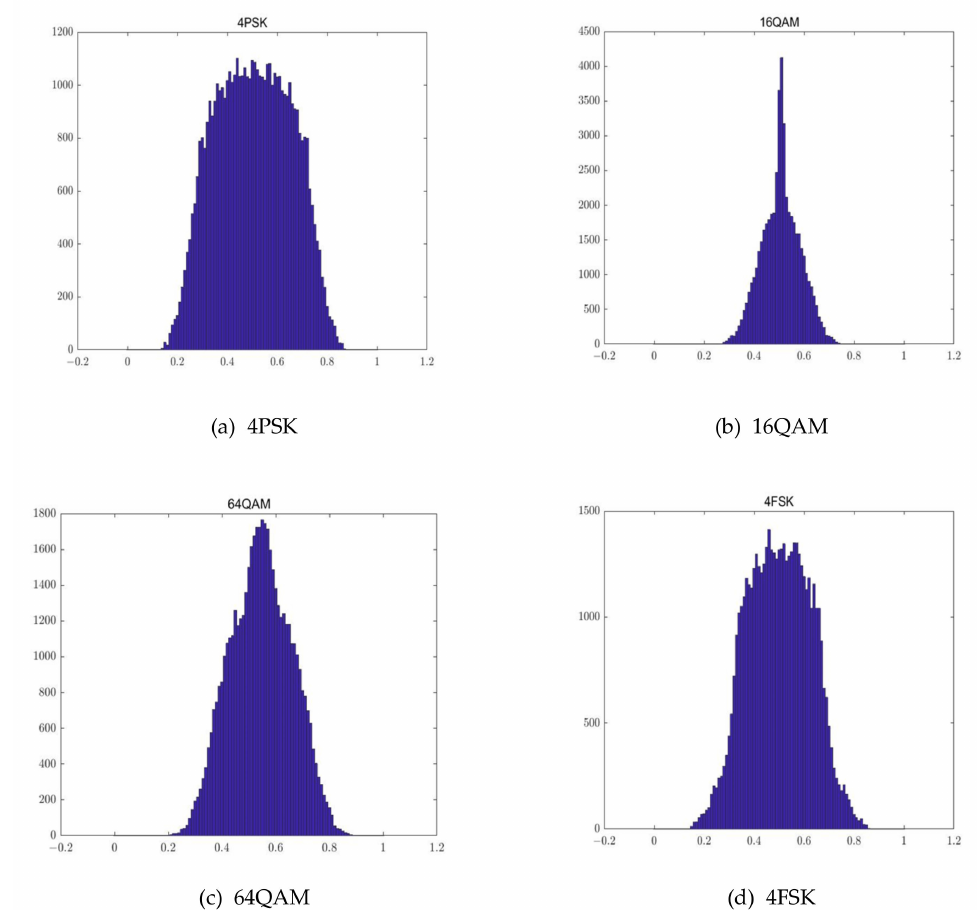
Figure 11. Amplitude histogram of modulated